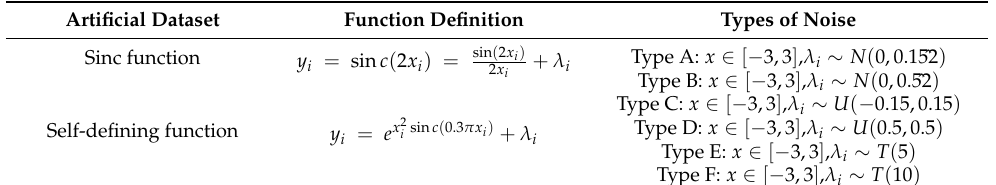
Table 1. Artificial datasets with different types of noise.